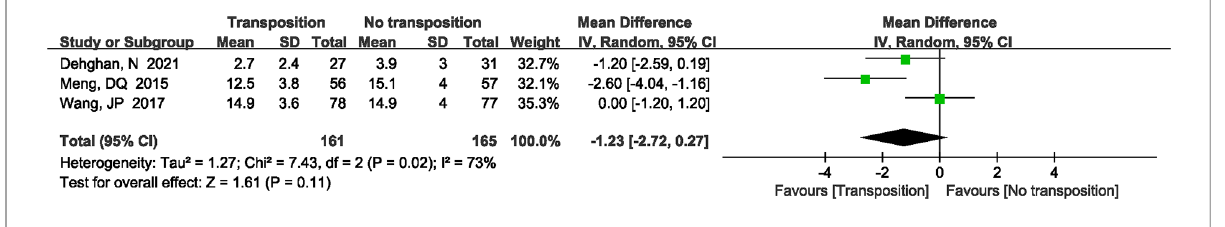
FIGURE 5 A forest plot showing the hospital stays.